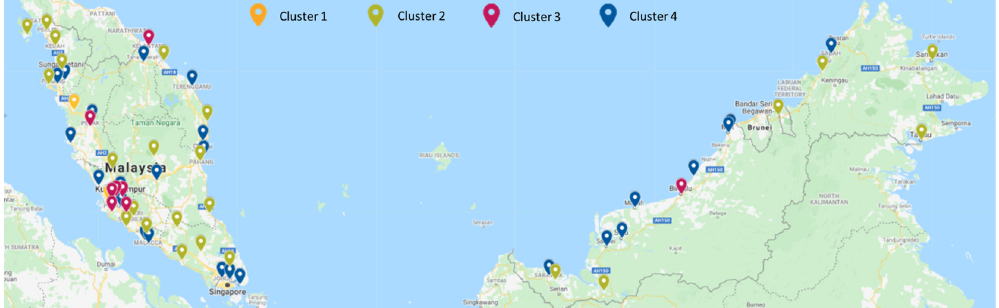
Figure 18. Air monitoring stations’ locations colored according to clusters for PM 10 daily maximum time series data with DTW and k-Means as its clustering algorithm.